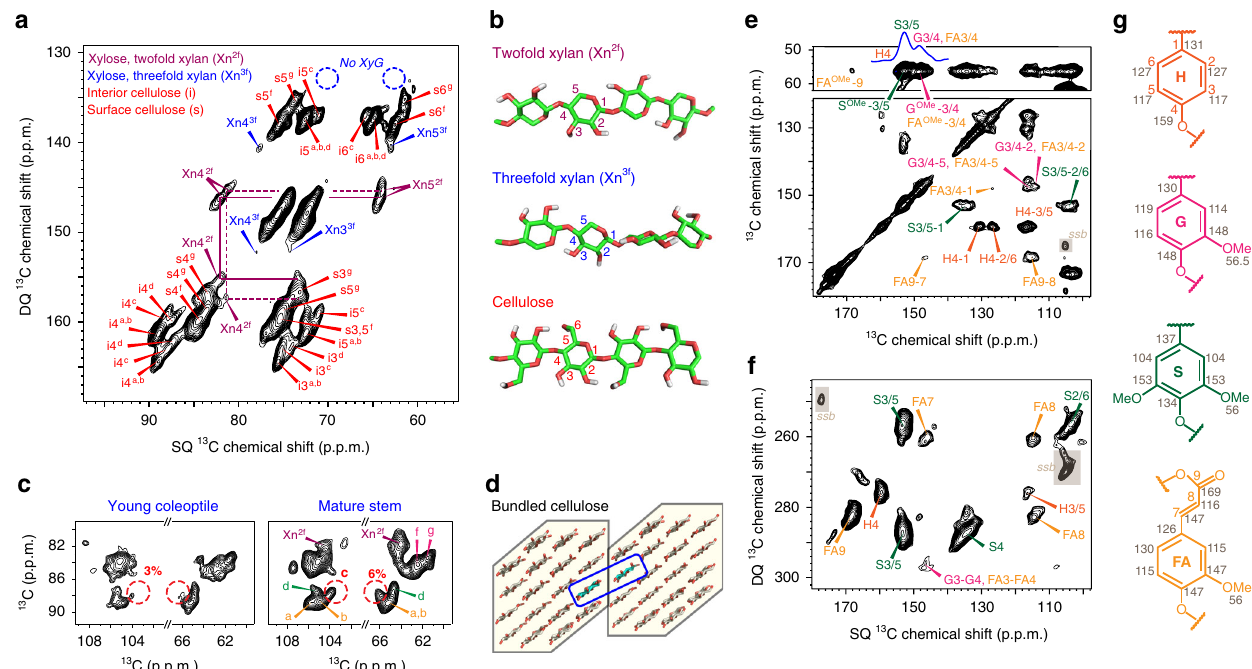
Fig. 1 The polymorphic structure of lignin and polysaccharides in intact maize stems. a Representative 2D 13 C – 13 C correlation spectrum resolves the polymorphic signals of cellulose and xylan. The xyloglucan (XyG) signals are missing (blue circles), indicating a negligible amount of primary cell walls. Abbreviations are used for assignment, e.g., s4 g is carbon 4 of glucose type-g on the micro fi bril surface. b Representative polysaccharide structures. c Cellulose signals in maize coleoptile and mature stems. The six cellulose allomorphs are labeled using letters a – g . The intensity of type-c cellulose is 2X greater in mature stems compared with coleoptiles. d An illustrative fi gure of two adjacent micro fi brils, with the restructured chains boxed in blue, which increase the intensity of type-c cellulose in c . These chains restructure by changing the hydroxymethyl conformation. The number of glucan chains in the fi gure may not represent the actual micro fi bril structure. The aromatic signals of lignin are resolved using 2D 13 C – 13 C spectra measured using e 53-ms CORD and f INADEQUATE methods. g Representative structures and 13 C chemical shifts of